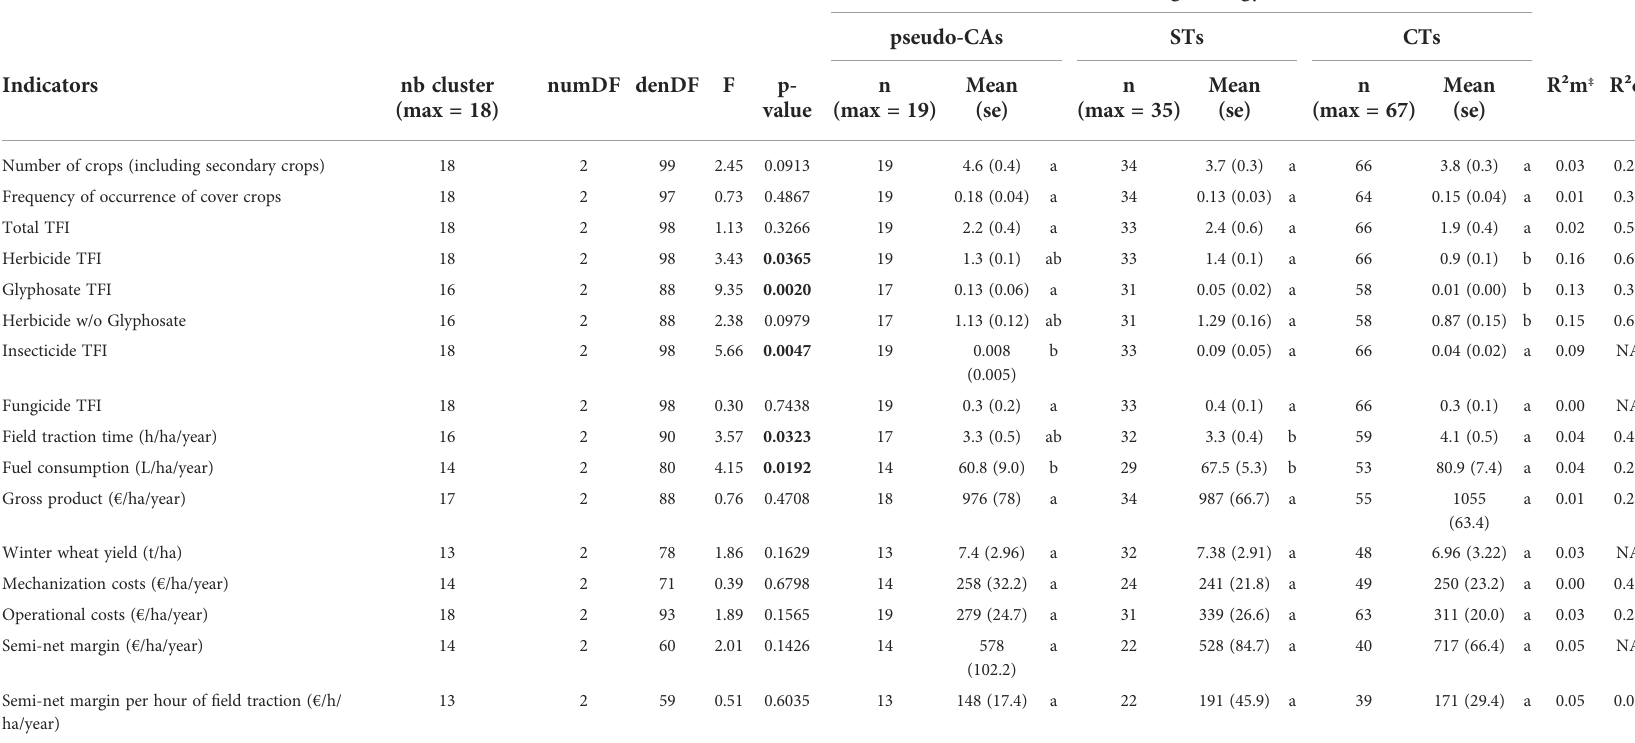
TABLE 2 Comparison of indicators between pseudo-conservation agriculture systems (pseudo-CAs) and their reference conventional tillage (CTs) and super fi cial tillage (STs) based systems, while accounting for production situation